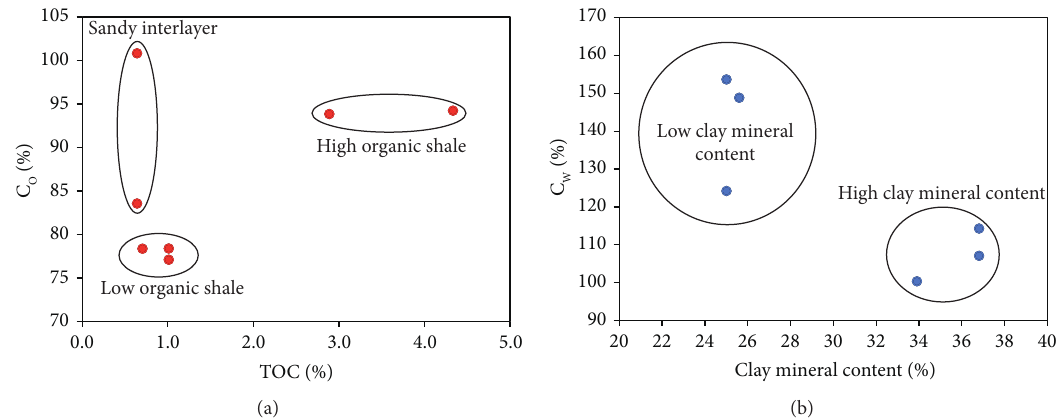
Figure 8: Relationship between TOC and clay minerals and oil-water imbibition. (a) Relationship between C between C w and clay mineral